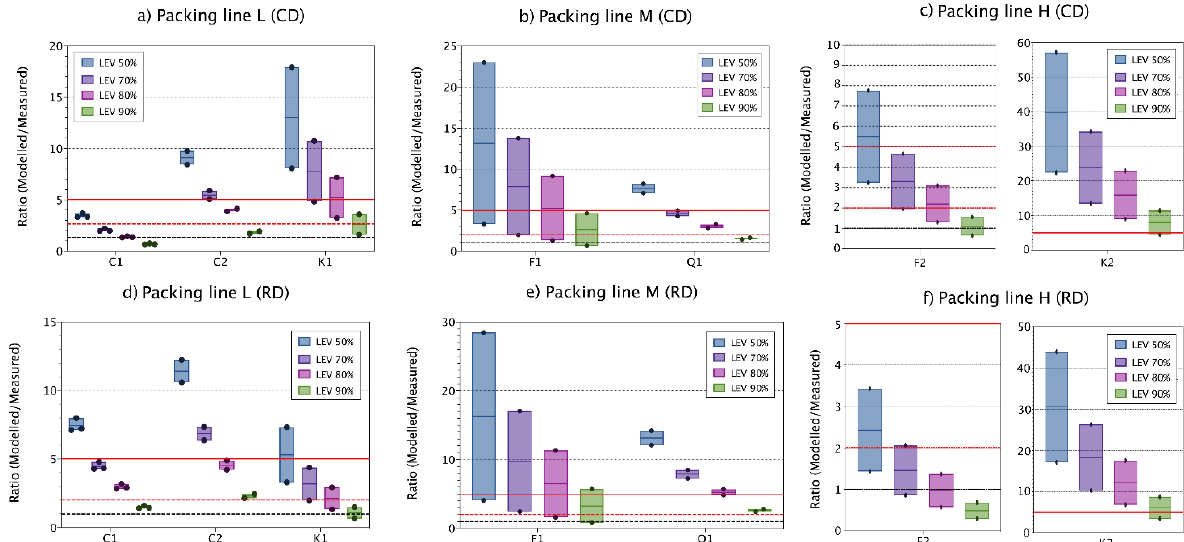
Figure 4. Vertical boxplot for ratio one-box modelled/measured respirable concentrations for all materials when using CD DI ( a – c ) and RD DI ( d – f ) as input parameter for source characterisation. Ratios 1, 2 and 5 are marked as reference (red solid line, red dashed line and black dashed lines, respectively). Solid coloured line within the box indicates the median value, the limits of the box indicate min and max values. Coloured dots represent the individual replicate values. Modelling parameters: β i fixed at 5 m 3 min −1 .